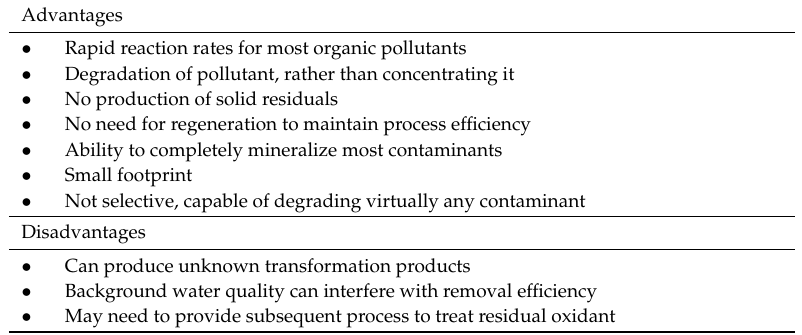
Table 1. Advantages and disadvantages of AOPs for treatment of organic contaminants in